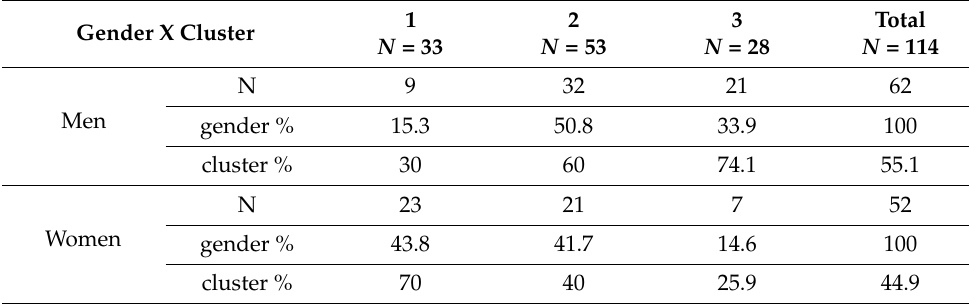
Table 11. Gender in different